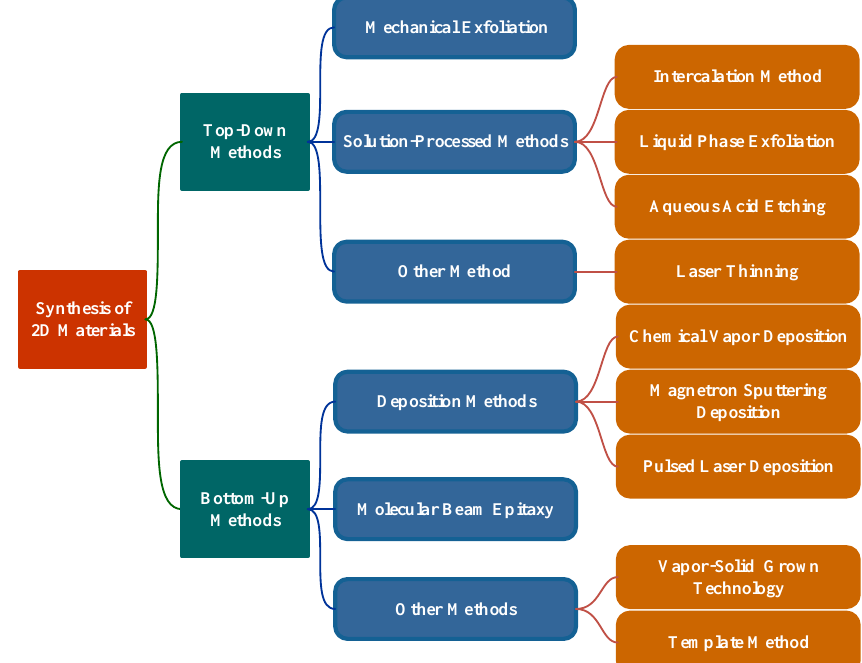
Figure 2. The synthesis of 2D